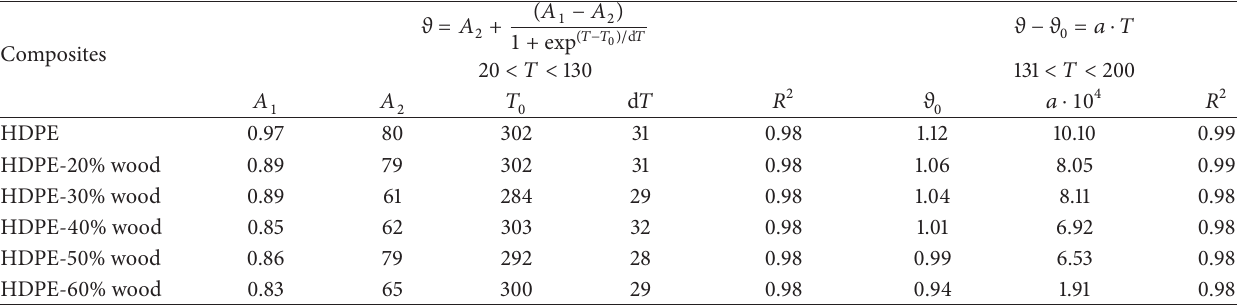
Table 4: Linear regression of specific volume according to the temperature and wood